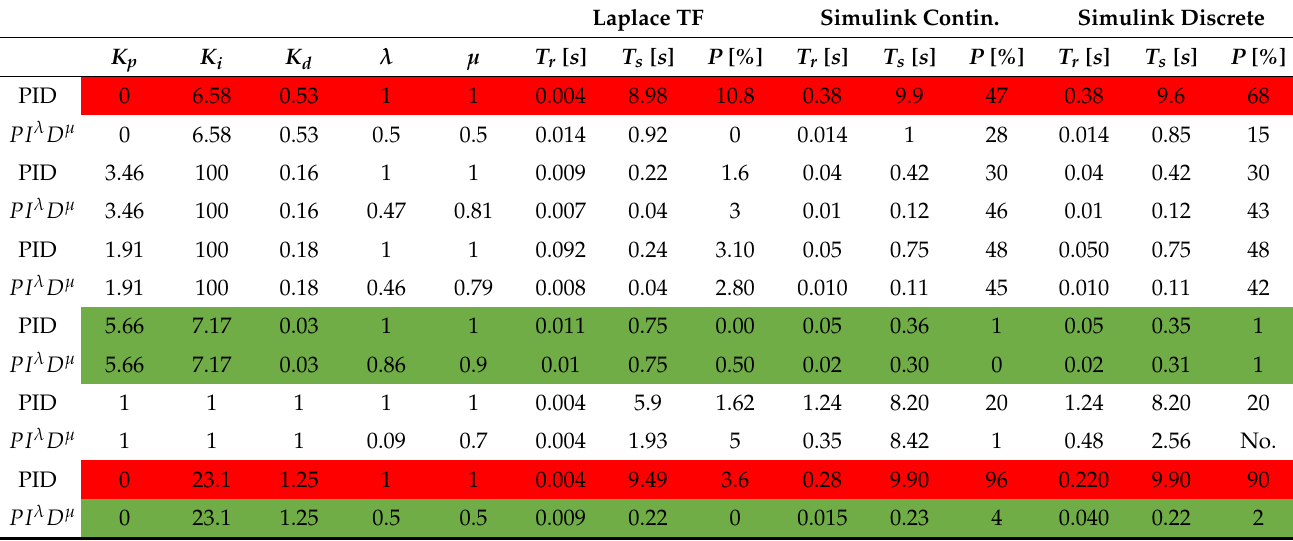
highlighted in green, and the worst parameters used for PID control in all domains are highlighted in red in Table 2. Table 2. Comparison of the step response of the DEA in the different domains of controller models. Laplace TF Simulink Contin.